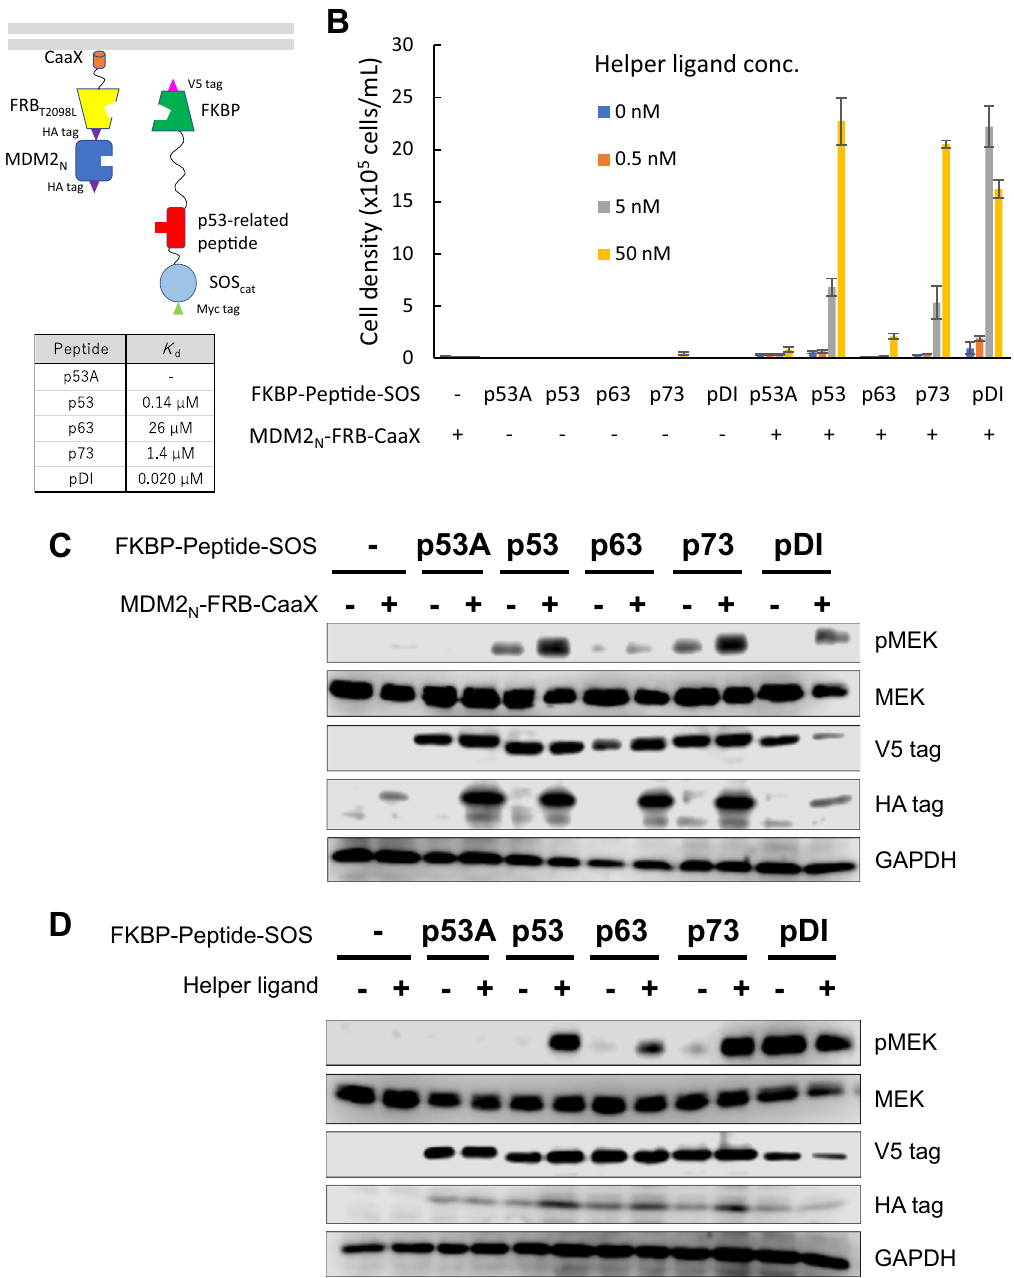
Figure 2. Proof of concept for H-SOLIS using MDM2–p53 interaction. ( A ) The design of the membrane- anchored and signaling chimeras incorporating MDM2 N and the p53-related peptides. The dissociation constants of each peptide binding to MDM2 N are also shown. ( B ) Cell growth assay. Cells were seeded at 1 × 10 5 cells/mL and cultured for 3 days in the medium with the indicated concentrations of the helper ligand AP21967. Viable cell densities are shown as mean ± SD (n = 3, biological replicates). ( C ) Comparison of signaling properties of the cells with or without MDM2 N -FRB-CaaX expression. Cells were stimulated for 15 min with 50 nM of the helper ligand AP21967 for all samples commonly. Phospho-MEK, whole MEK, V5 tag (FKBP-Peptide-SOS expression), HA tag (MDM2 N -FRB-CaaX expression), and GAPDH (loading control) were detected using corresponding primary antibodies. ( D ) The helper ligand-dependent signaling of the cells commonly expressing MDM2 N -FRB-CaaX. Cells were stimulated for 15 min with or without 50 nM of the helper ligand AP21967. Uncropped blot images for ( C ) and ( D ) are provided in Supplementary Fig.